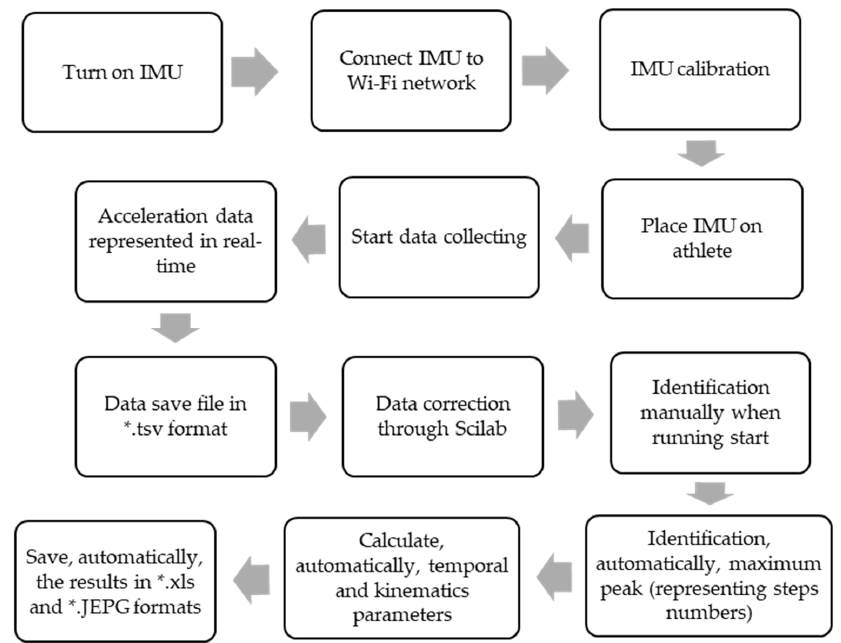
Figure 2. The operating steps of the IMU (for data treatment and processing).